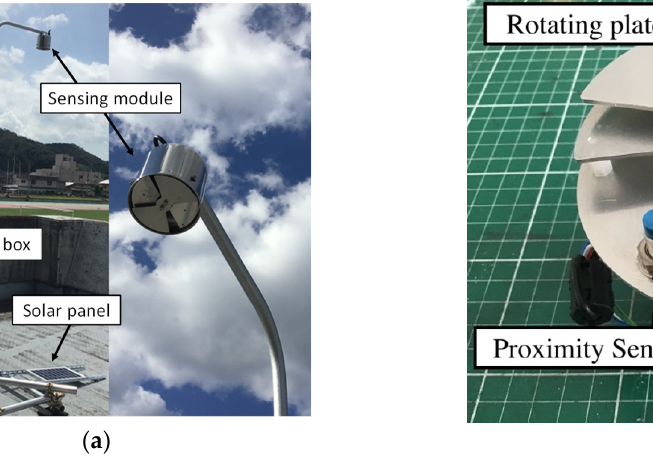
Figure 1. ( a ) Overview of the EFM system developed in this study (left) and picture of the sensing module (right). This system was installed at Honjo station. ( b ) Picture of sensing module, which consists of a base plate, sensing plates, a rotating plate, and a proximity sensor.